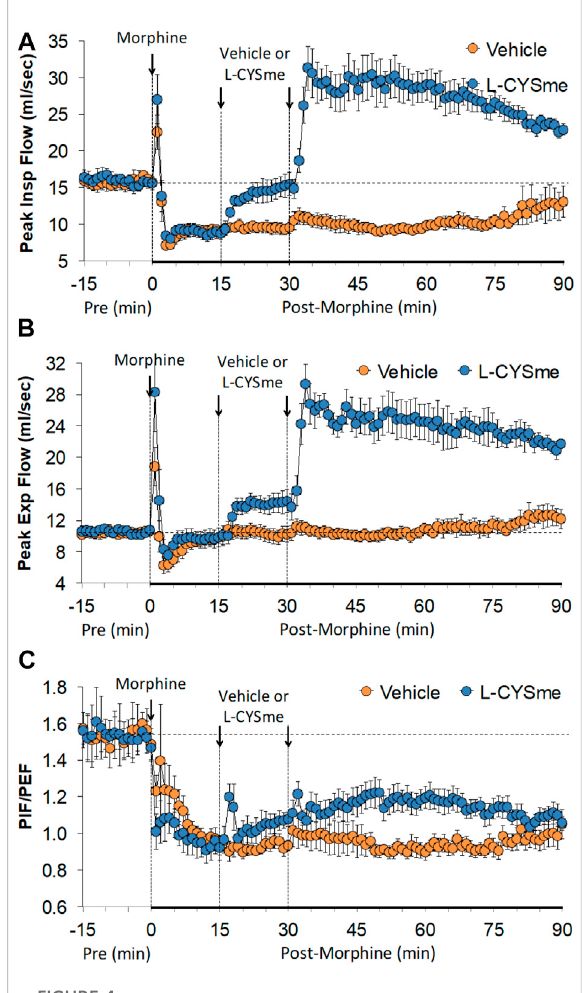
FIGURE 4 Peak inspiratory fl ow (Panel (A) , peak expiratory fl ow (Panel (B) and peak inspiratory fl ow/peak expiratory fl ow (PIF/PEF) (Panel (C) prior to (Pre), following the injection of morphine (10 mg/kg, IV), and then two injections of vehicle or L-cysteine methyl ester (L-CYSme, 500 μ mol/kg, IV) given 15 min apart, in freely- moving rats. The data are presented as mean ± SEM. There were 6 rats in each